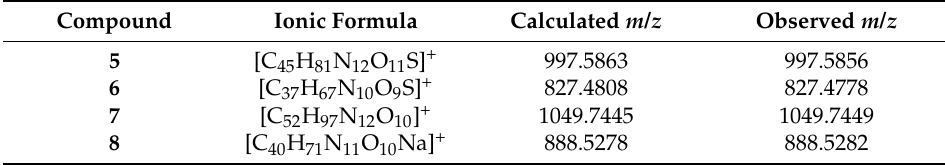
Table 1. The high-resolution mass spectrometry (HRMS) analysis of the purified compounds 5 – 8 a